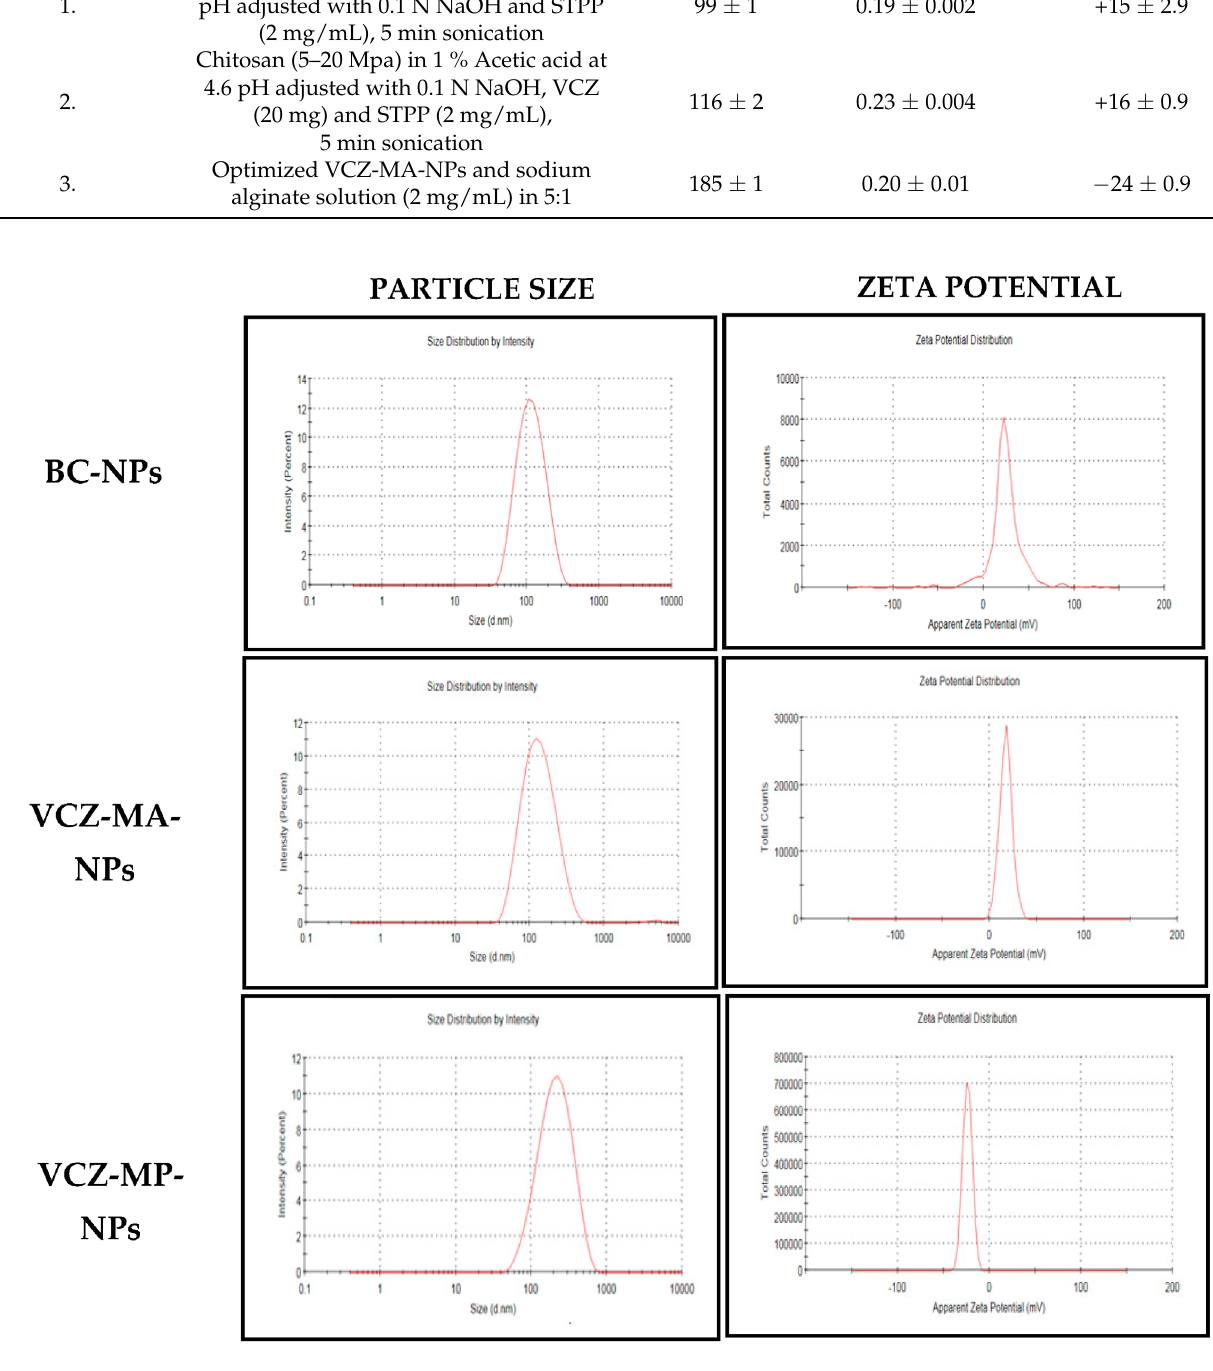
Figure 4. Graphs from dynamic lights catering (DLS) showing particle size, PDI, and zeta potential of optimized batches (BC-NPs, VCZ-MA-NPs, and VCZ-MP-NPs). The FT-IR spectrum of VCZ-MA-NP exhibits peaks at 3211, 2935, and 1082 cm −1 that are similar to those obtained in the spectrum of chitosan. There are no prominent peaks of voriconazole obtained in the spectrum of MA-NPs, indicating the encapsulation of the drug in the nanoparticles. The VCZ-MP-NPs spectrum exhibits peaks at 1589 and 958 cm −1 , and the presence of no characteristic peaks of chitosan and voriconazole, ensuring the coating of the chitosan nanoparticles with sodium alginate. No extra peaks discovered in the physical mixture of drug and excipients confirm the compatibility of drug and formulation components (Figure 5). The NMR spectrum of VCZ showed that the hydroxyl group (OH) had a chemical shift of 5.98 ppm, and aromatic OH had a chemical shift of 7.28 ppm. The NH 2 group of the triazole ring had a chemical shift of 4.8 ppm. This confirms the purity of the drug. The NMR spectrum of VCZ-MA-NPs is similar to the chitosan NMR spectrum ( δ 4.56 ppm ) and drug’s peak. In VCZ-MP-NPs, the dominant peaks are 4.2, 3.45, and 1.04 ppm, the characteristics of sodium alginate and chitosan polymers. The absence of extra peaks confirms the lack of impurity (Figure 6). The optimum pH range reported for the ocular formulation is 6.6–7.8, and formulation outside this specified pH range can cause ocular irritation leading to lacrimation, pain, redness, and discomfort. The pH of the mucoadhesive and modified nanoparticles was found to be in the range of